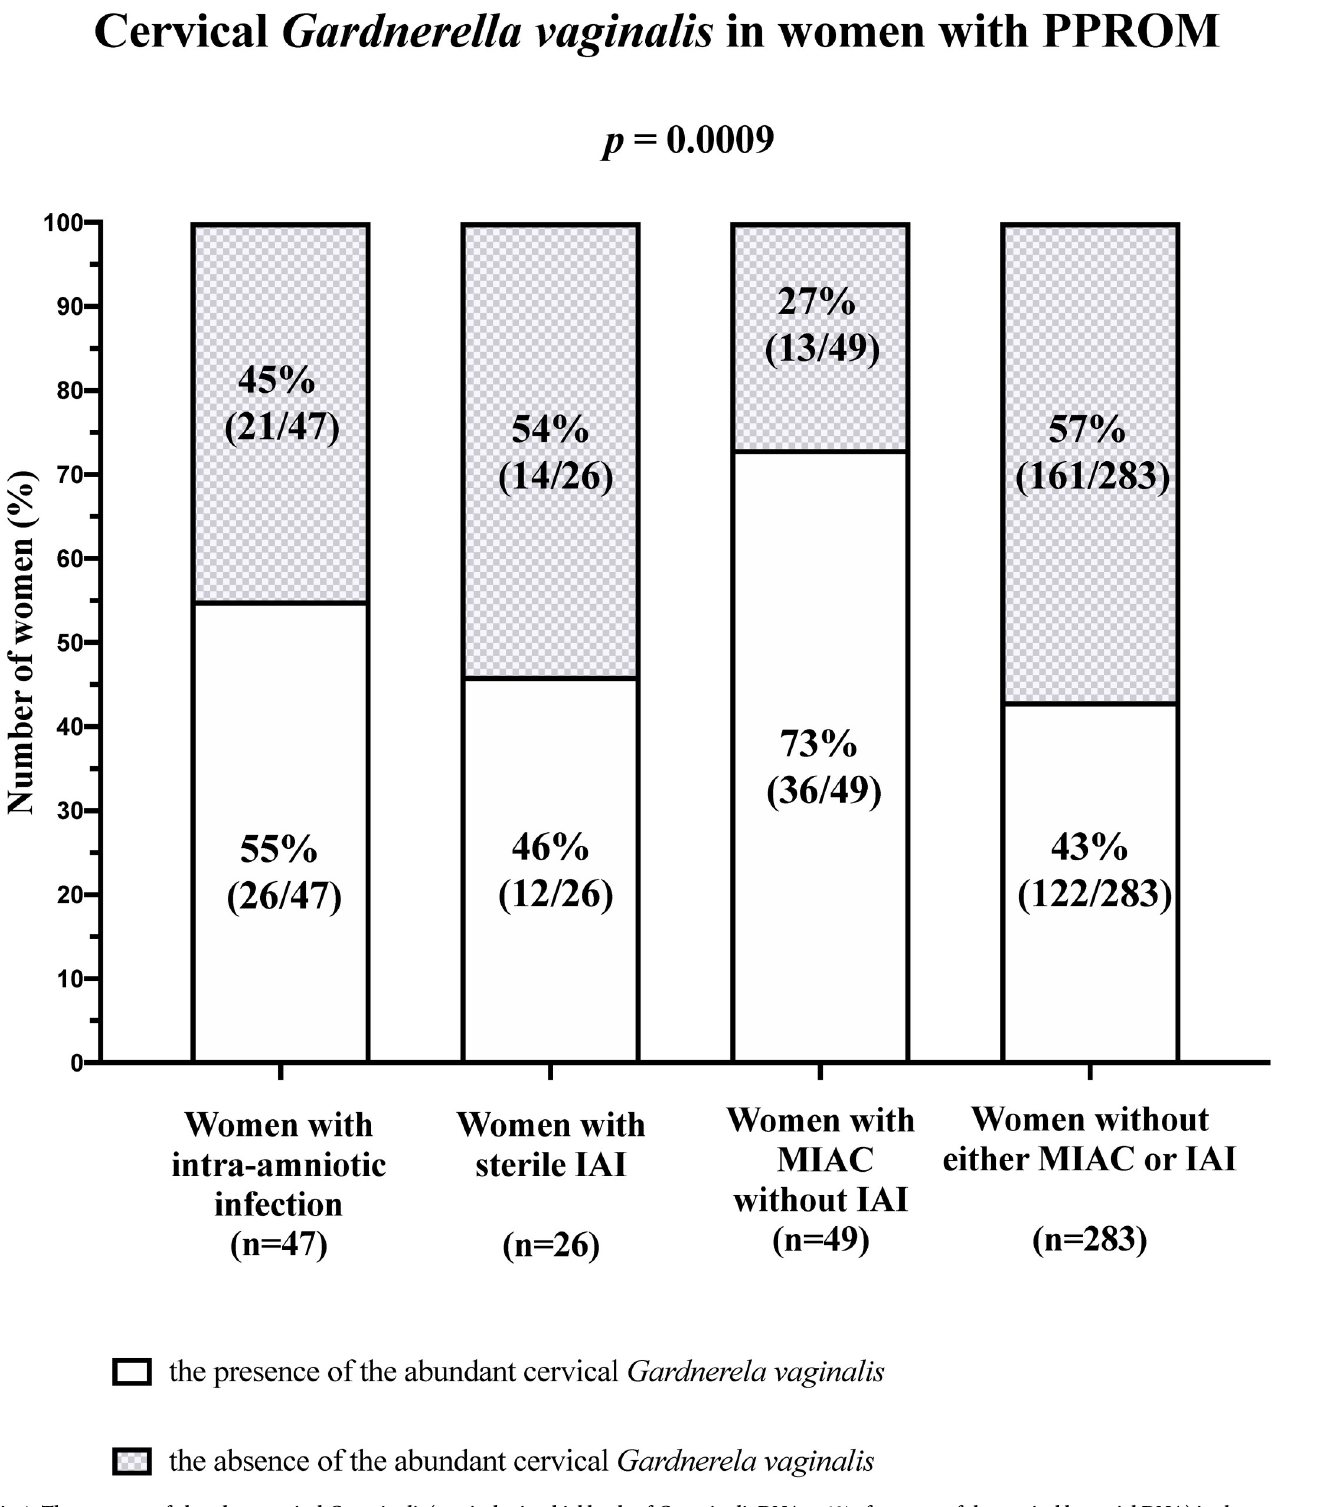
Fig 4. The presence of abundant cervical G . vaginalis (cervical microbial loads of G . vaginalis DNA > 1% of amount of the cervical bacterial DNA) in the women with preterm prelabor rupture of the membranes with respect to the presence of microbial invasion of the amniotic cavity and/or intra-amniotic inflammation. A difference in the rates of the abundant cervical G . vaginalis was identified among the women with intra-amniotic infection, sterile IAI, MIAC without IAI, and without either MIAC or IAI ( p = 0.0009). Abbreviations: IAI, intra-amniotic inflammation; MIAC, microbial invasion of the amniotic cavity.